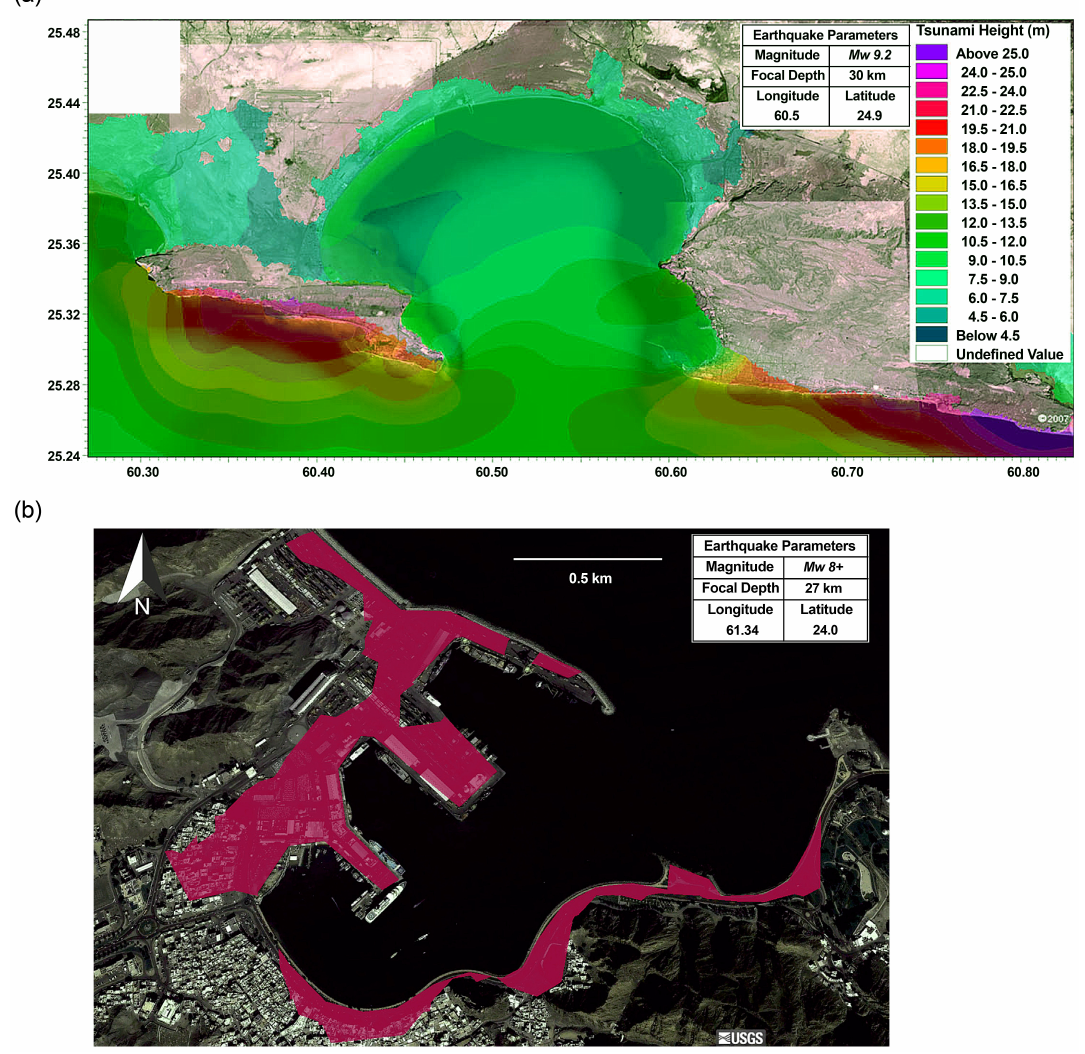
Figure 6. ( a ) Tsunami inundation map for the Chabahar bay, Iran from a M w 9.2 earthquake scenario in the MSZ (modified after [101]). ( b ) Tsunami inundation map for the Muscat, Oman from a M w 8 + earthquake scenario in the eastern Makran (modified after